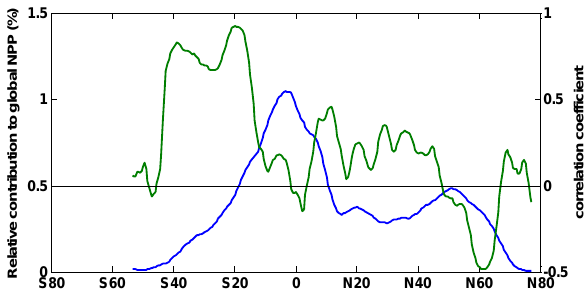
Fig. 5. Correlation coefficients of latitudinal zone averaged NPP and Figure 5, Correlation coefficients of latitudinal zone averaged NPP and SPEI (green) and NPP 542 SPEI (green) and NPP contributions as a percentage of global NPP contributions as a percentage of global NPP (blue). 5-degree moving averages were applied to 543 (blue). 5-degree moving averages were applied to all 0.5-degree all 0.5-degree steps along latitude. 544 steps along